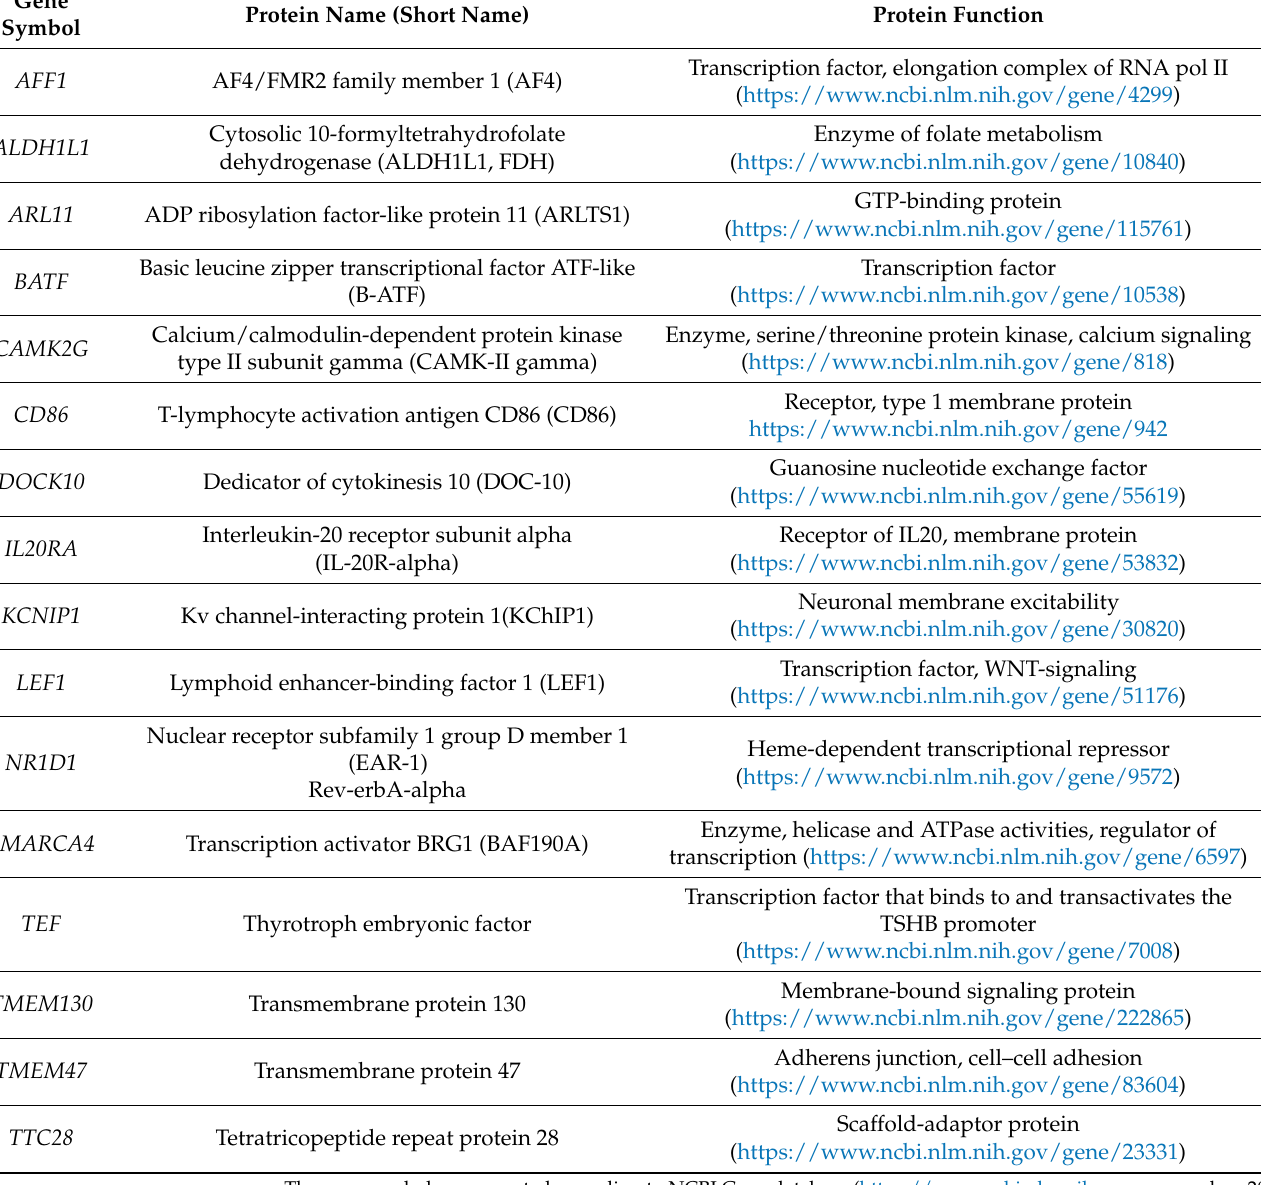
Table 2. Names and function of proteins encoded by MS-GWAS genes differentially expressed between MS and control IJV